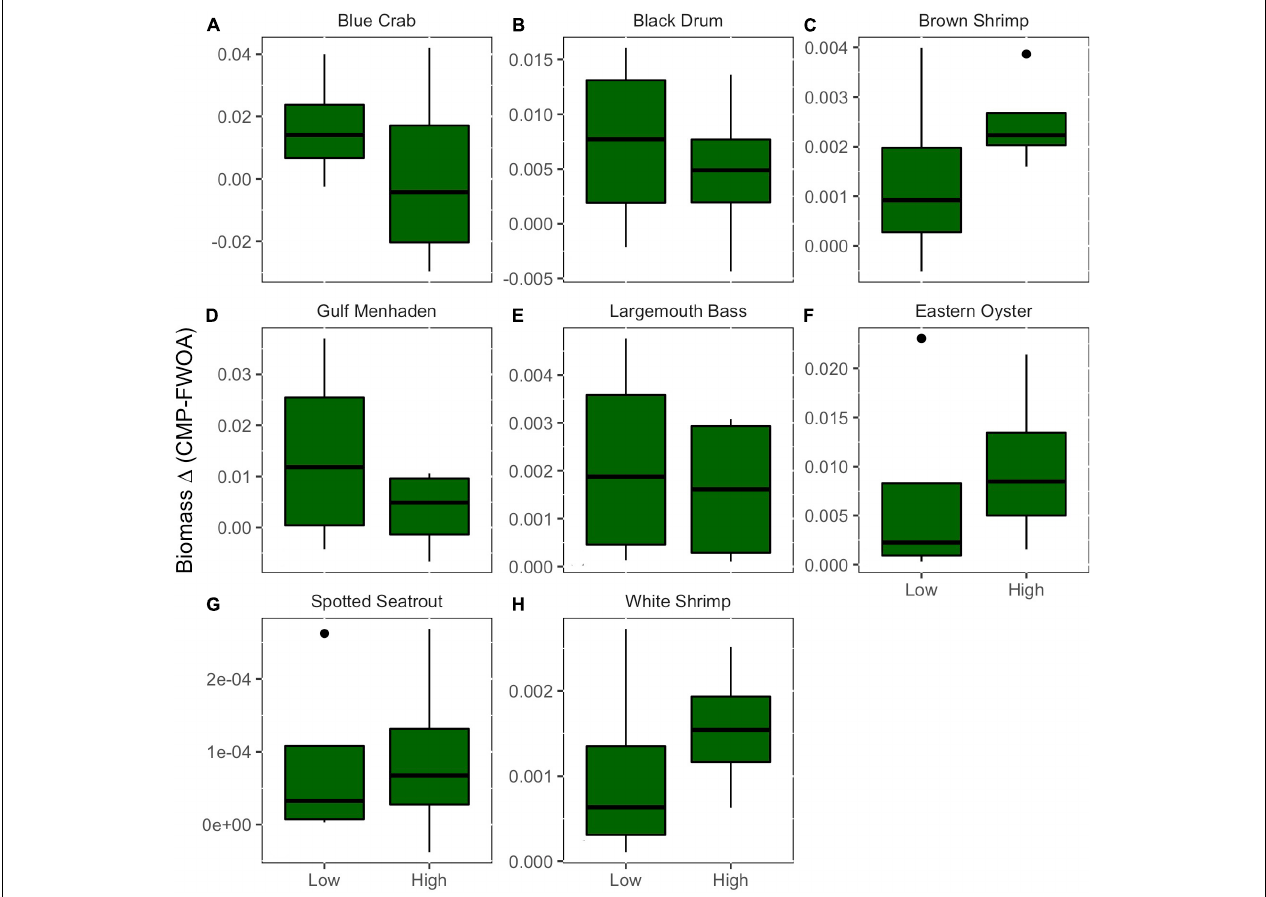
FIGURE 14 | The average difference in biomass over all basins of eight species of economic interest between Coastal Master Plan (CMP) implementation and a future without action (FWOA). This difference under a low and high sea level rise scenarios is compared. Values indicate how much more biomass in g m − 2 is retained at year 50 with plan implementation as compared to a future without action. (A) Blue Crab, (B) Black Drum, (C) Brown Shrimp, (D) Gulf Menhaden, (E) Largemouth Bass, (F) Eastern Oyster, (G) Spotted Seatrout, (H) White